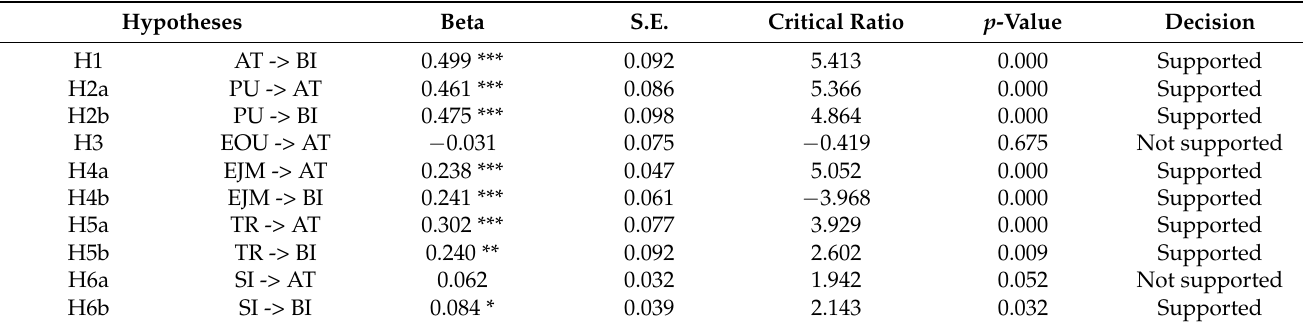
Figure 2. Structural equation model with parameter estimates. * p < 0.05, ** p < 0.01, *** p < 0.001. Non-significant paths are shown in dotted lines. Note. PU = perceived usefulness; EOU = perceived ease of use; EJM = enjoyment; TR = trust; SI = social influence; AT= attitude; BI=behavior intention. Table 4. Result of structural model